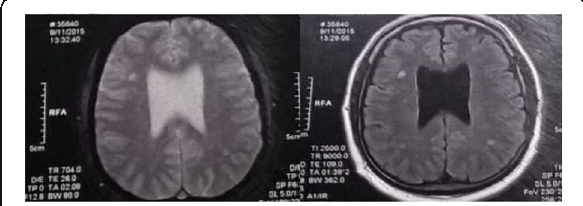
Fig. 1 (abstract P035). Left image indicating subcortical hyperintense focus and deep in the supratentorial white matter, from non-specific nature in T2. Right image indicating the same lesions, on